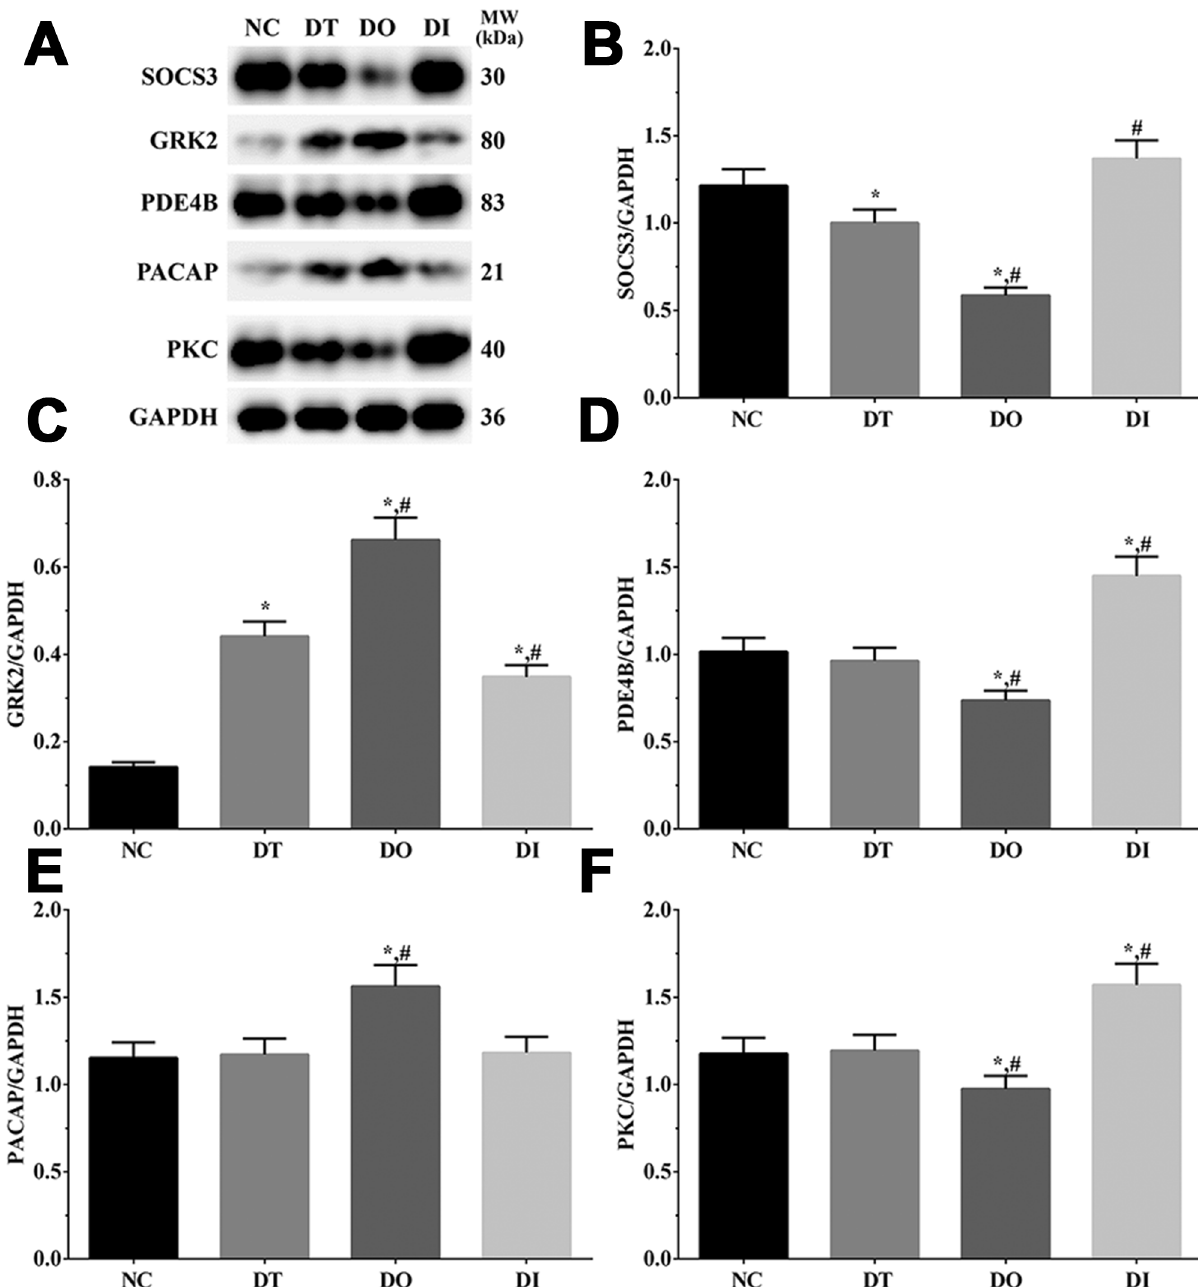
Figure 5 – Detection of neuron protective factors in glial cells. (A) Western blotting analysis of SOCS3, GRK2, PDE4B, PCACP and PKC in glial cells. (B-F) Quantitative analysis of each target protein. Data was presented as mean ± SD, each experiment was repeated for three times. *P<0.05 vs NC group of cells. #P<0.05 vs signal dezocine treatment group. NC: normal group, DT: dezocine treatment group, DO: dezocine treatment combined with RAPGEF3 overexpression group, DI: dezocine treatment combined with RAPGEF3 inhibition group. SH: sham group, TD: dezocine treatment group, TO: dezocine treatment combined with RAPGEF3 overexpression group, TI: dezocine treatment combined with RAPGEF3 inhibition